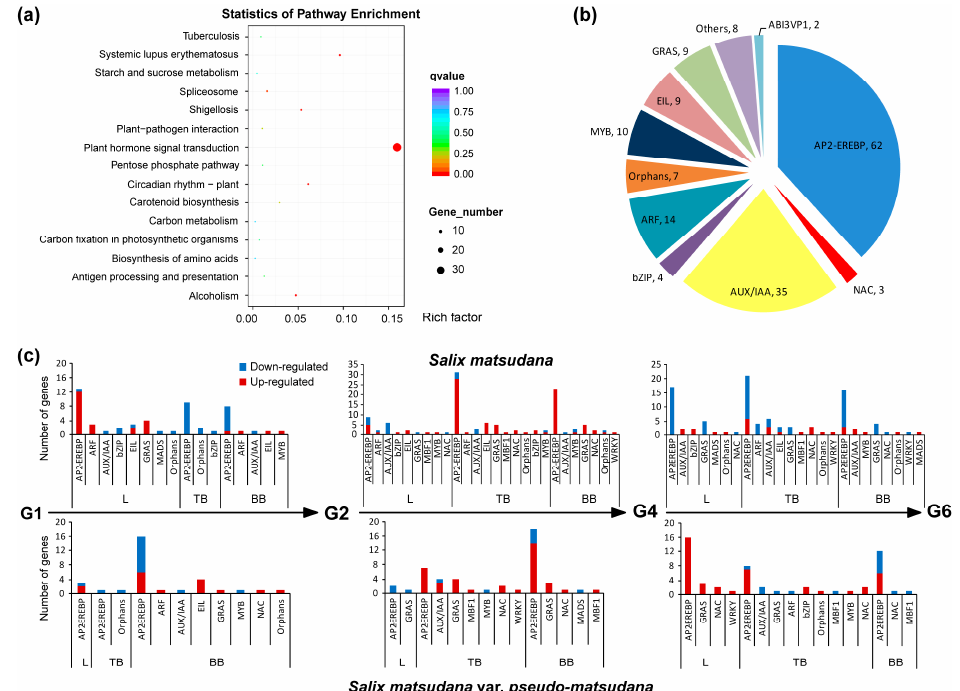
Figure 6. Transcription factors associated with hormones in willow. ( a ) Statistics of pathway enrichment analysis. Horizontal axis, enrichment factor; vertical axis, pathway category. ( b ) Family assignment of hormone-related transcription factors. Number of genes assigned to each family shown after the comma. ( c ) Number of differentially expressed transcription factors at development stages. L, leaf; TB, top branch; BB, basal branch.